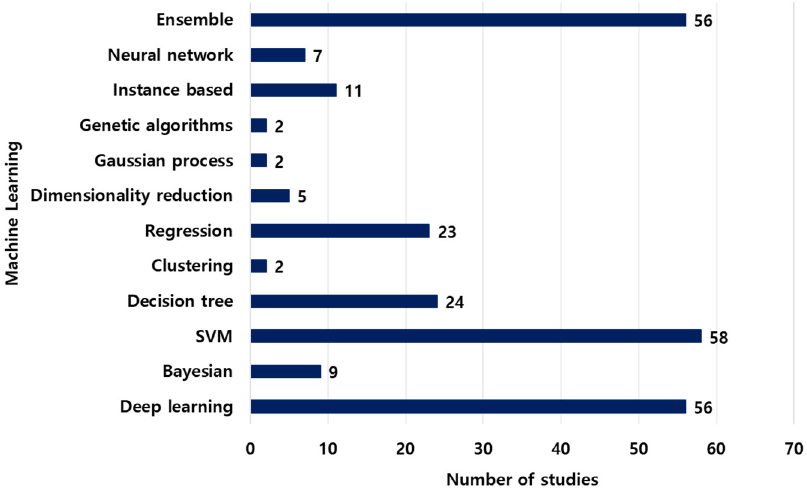
Figure 8. Usage frequencies of ML models.